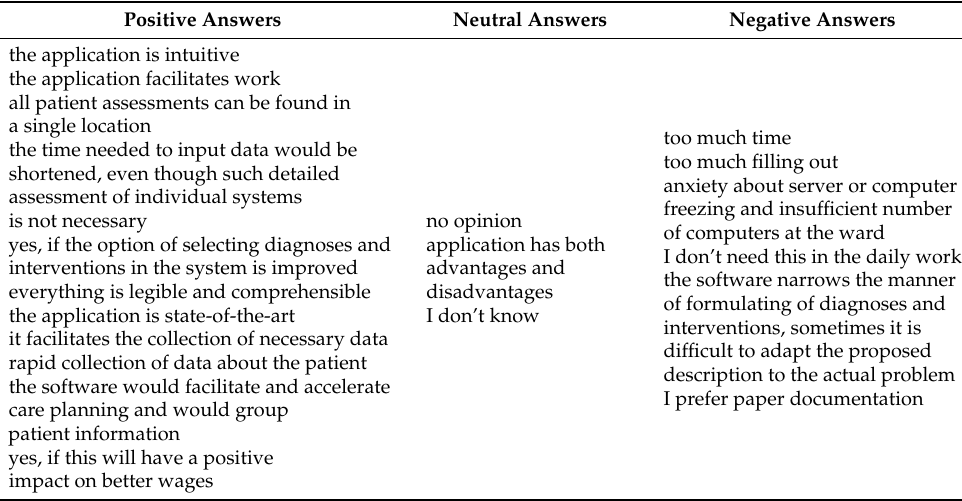
Table 1. Responses of the surveyed to question 18 from the survey.